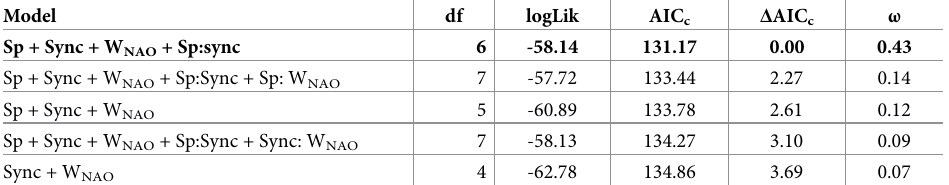
Table 1. Modelling of egg volume of yellow-legged gulls and Scopoli’s Shearwaters on Dragonera Natural Park, Spain.